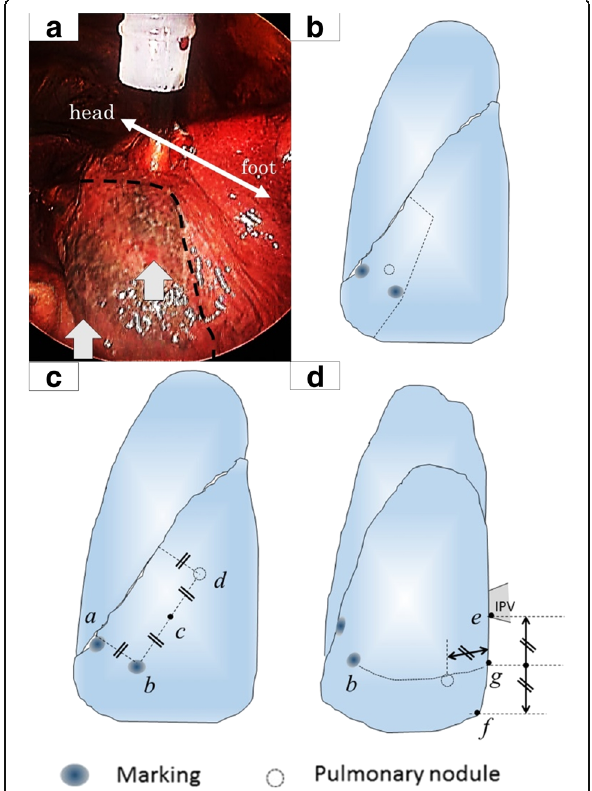
Fig. 2 Intraoperative view of markings and three-dimensional images. a An intraoperative thoracoscopic view of the lung showing two markings ( white arrowheads ) indicating the location of the tumor in S8 and resec- tion lines for S8 segmentectomy ( interrupted line ). b A three dimensional view showing the S8 tumor, two markings and resection lines for S8 segmentectomy. c A three-dimensional view showing the newly found S6 nodule, two markings, and imaginary auxiliary lines. d A three- dimensional view showing the newly found S10 nodule, two markings, and the inferior pulmonary